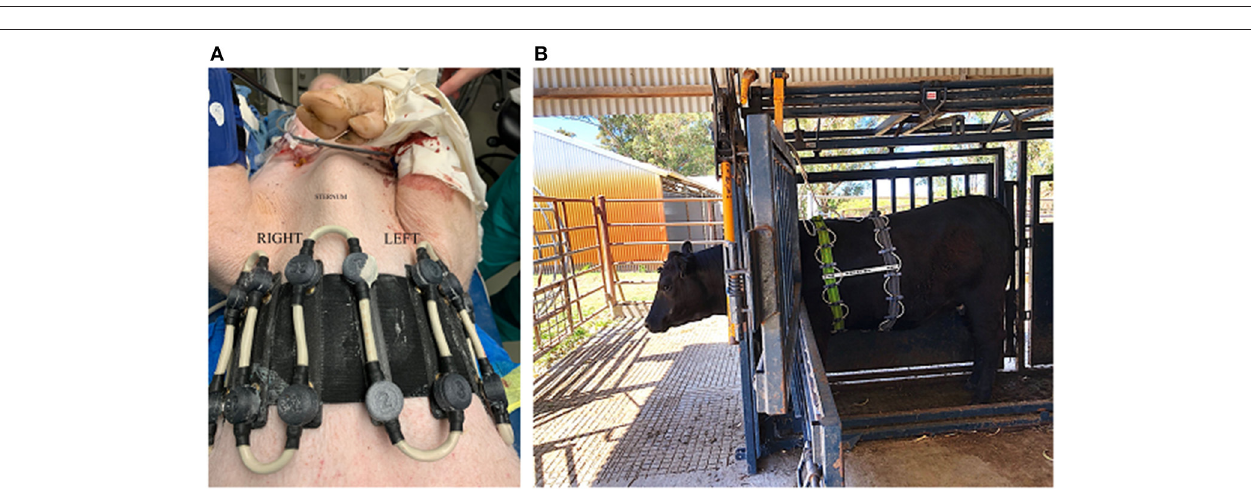
FIGURE 6 | Two-plane EIT belts. (A) On a pig lying in dorsal recumbency (cranial is to the top of the picture) with 32 electrodes in two electrode planes on one electrode belt and one continuous cable belt. (B) On a standing cow restrained within a crush, consisting of two electrode belts with 16 electrodes each, with spacers between the rows, and a separate cable belt on two stretchable electrode belts. In the pig and cow EIT set-up, the separate cable belt attaches to the stretchable electrode belt via metal fastenings that can be attached and detached as necessary.